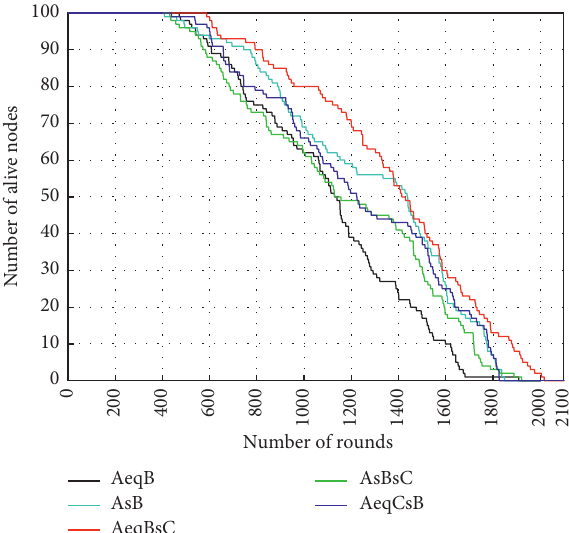
a < S b . (b) Partitioning scheme 2: S a